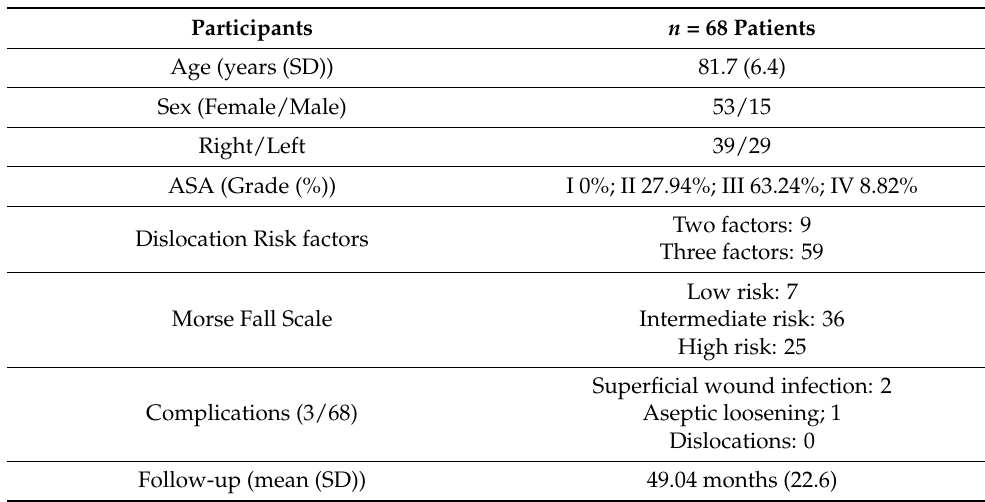
Table 2. Demographic data and baseline characteristics of the study